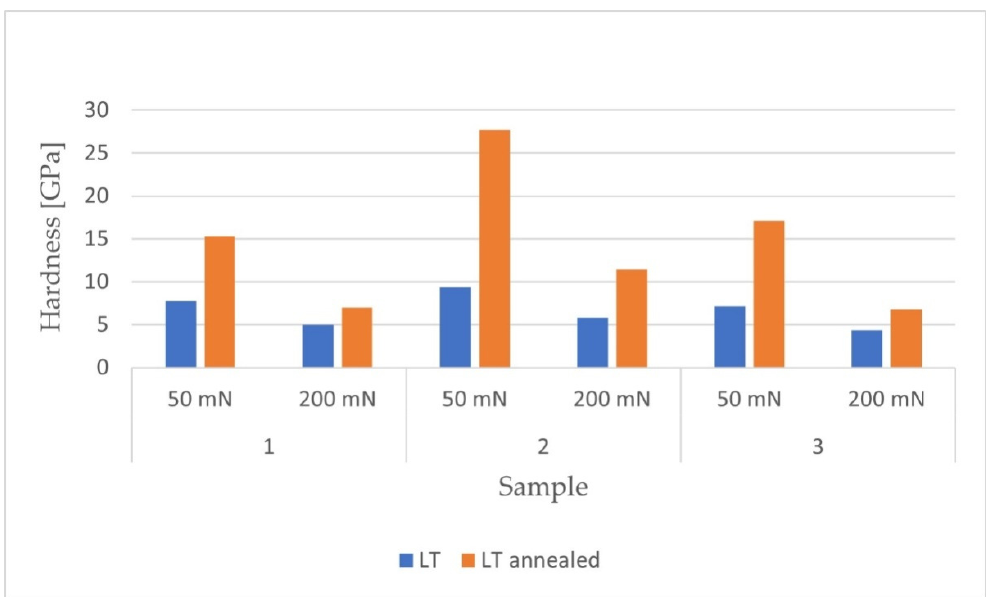
Figure 9. Values of hardness obtained after melting for two maximum loadings: 50mN and 200 mN.